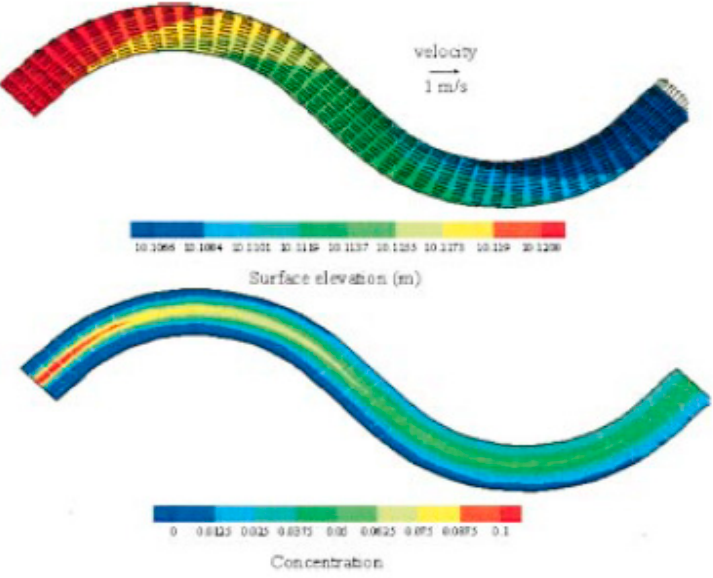
Figure 12. Flow and concentration field (Reproduced from Duan (2004) [50] with permission from ASCE).